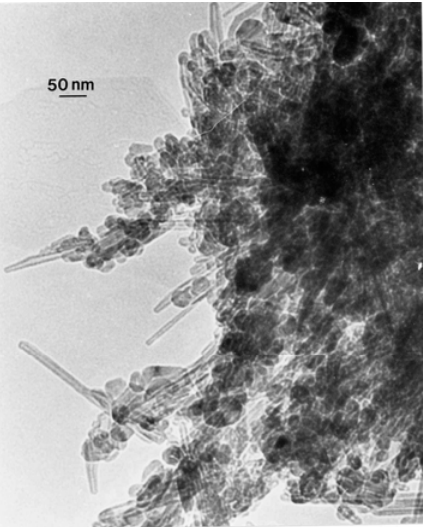
Figure 7: Large (~2 µm) carbon nanotube aggregate collected from a kitchen natural gas burner exhaust stream. The estimated primary nanoparticle (MWCNTs and fullerene nanopolyhedra) number is ~8000. The TEM image shows only about one-fourth of the total aggregate.